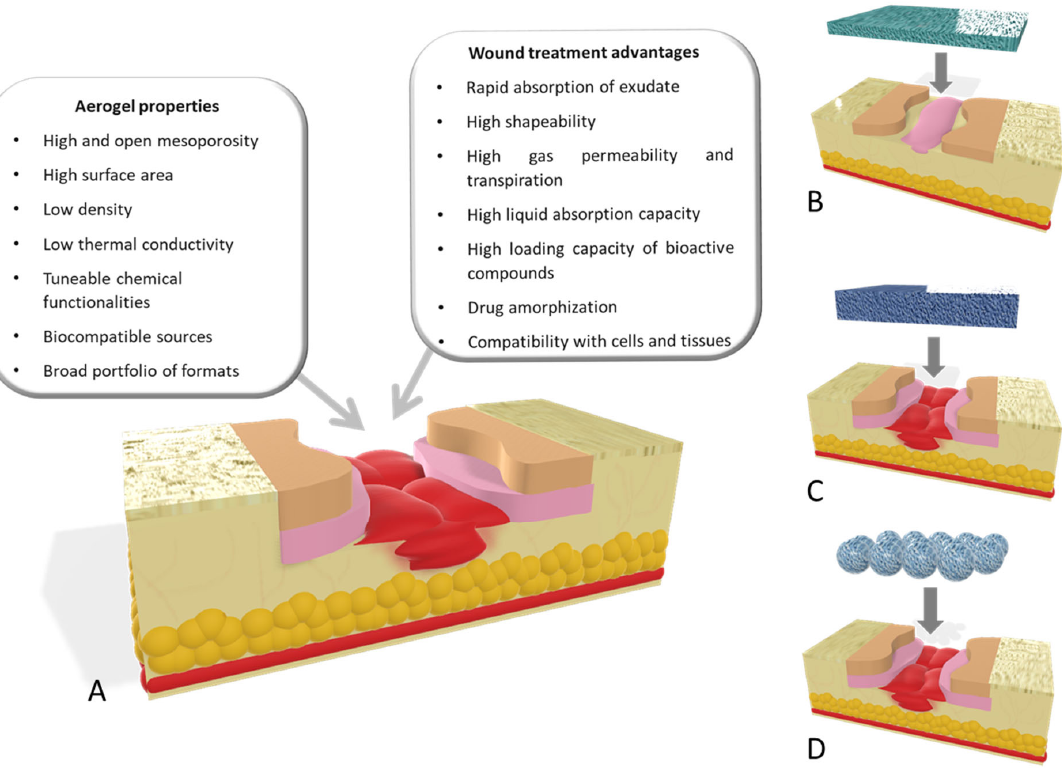
Figure 3. ( A ) Aerogel properties that are of utmost importance for wound healing. Different aerogel formats used: ( B ) aerogel films for wound healing applications in low-thickness wounds; ( C ) scaffolds; and ( D ) aerogel particles as wound healing applications for high-thickness wounds.